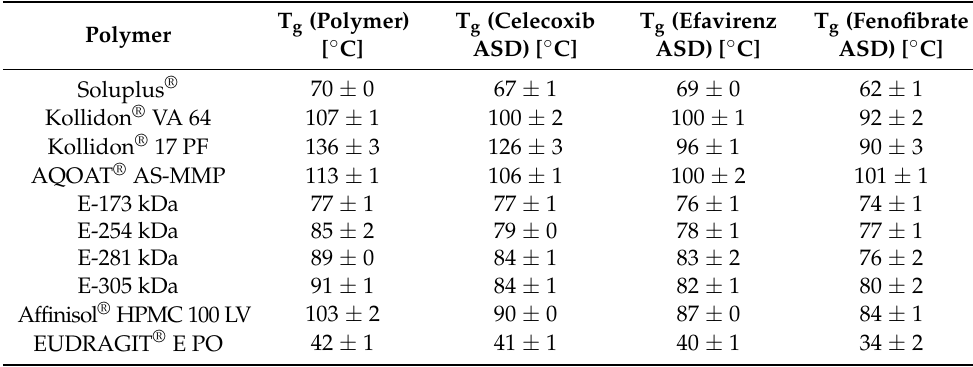
Table 6. Glass transition temperatures (T g ) of pure (co-)polymers and amorphous solid dispersions (ASDs) incorporating celecoxib, efavirenz or fenofibrate. Each value designates the mean ± S.D. (n = 3).